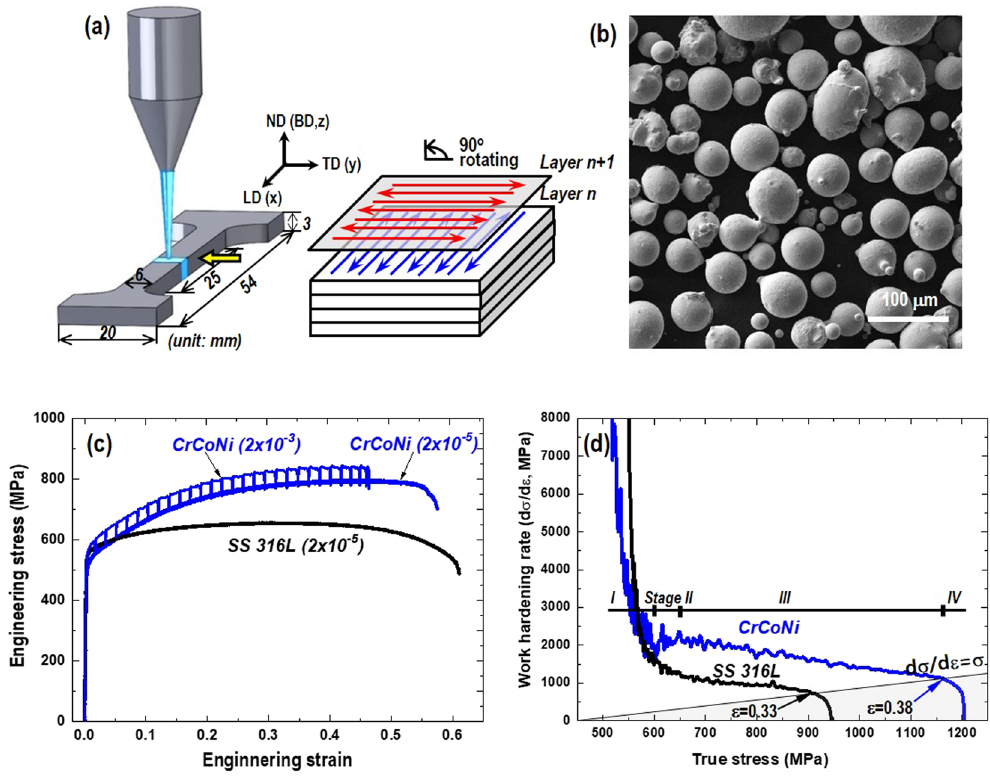
Figure 1. ( a ) Schematic of the sample dimension and orthogonal scanning strategy, ( b ) powder size and morphology for the additive manufacturing (AM) process, ( c ) engineering stress-strain curves of tensile tested with the strain rate of 2 × 10 − 5 s − 1 for AM stainless steel 316 L and AM CrCoNi specimens. Included tensile test result of 2 × 10 − 3 s − 1 for AM CrCoNi specimen and ( d ) work hardening rate (d σ /d ε , MPa) as a function of true stress.